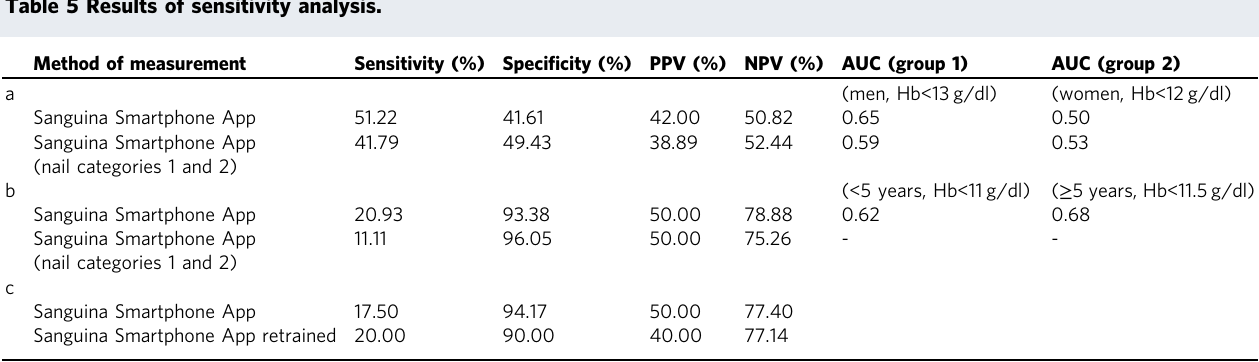
Table 5 Results of sensitivity analysis. Method of measurement